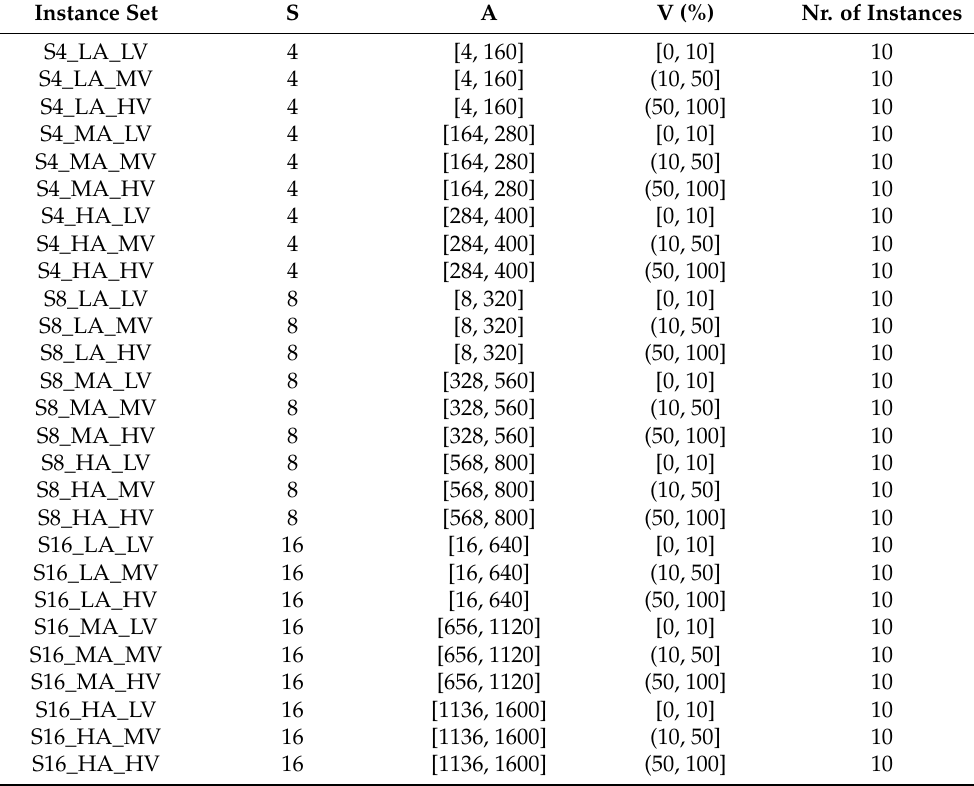
Table 1. Characteristics of the defined instance sets.